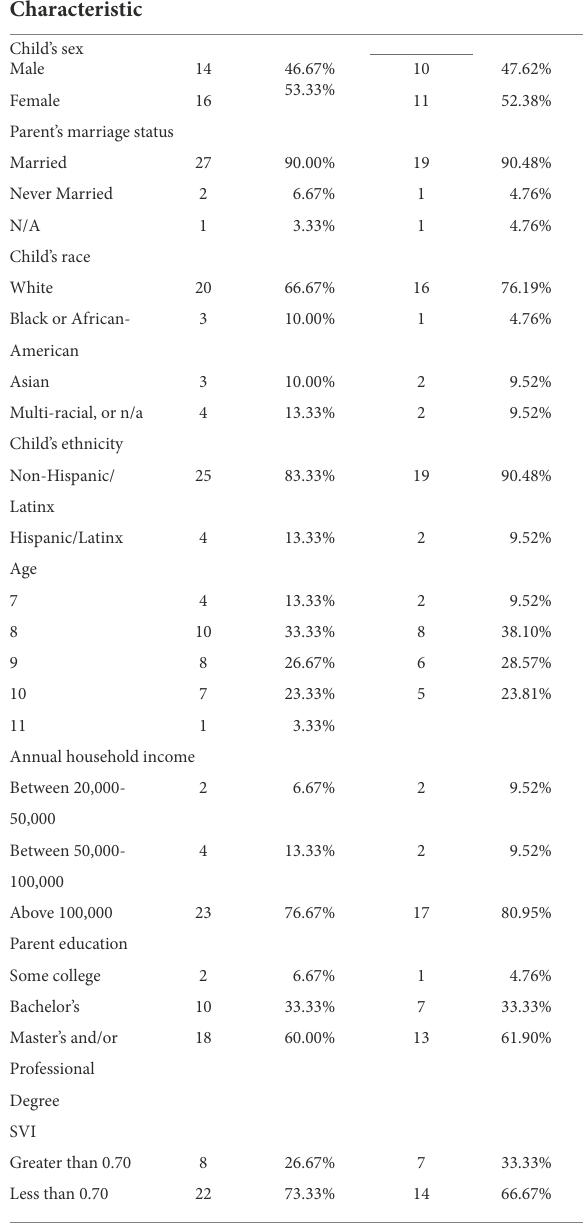
TABLE 1 Demographic breakdown for the full sample ( N = 30) and the sample with complete data ( n = 21). Initial